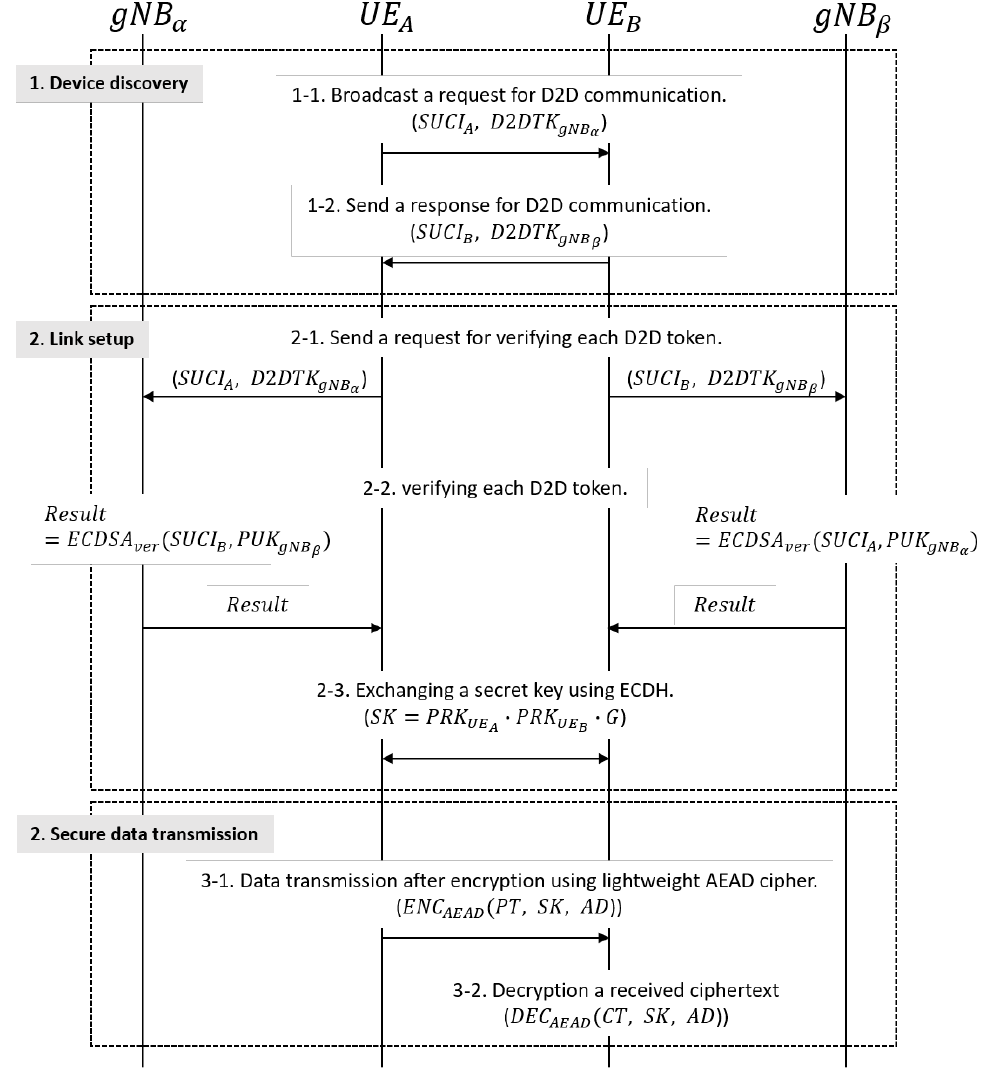
Figure 3. The whole process of secure D2D